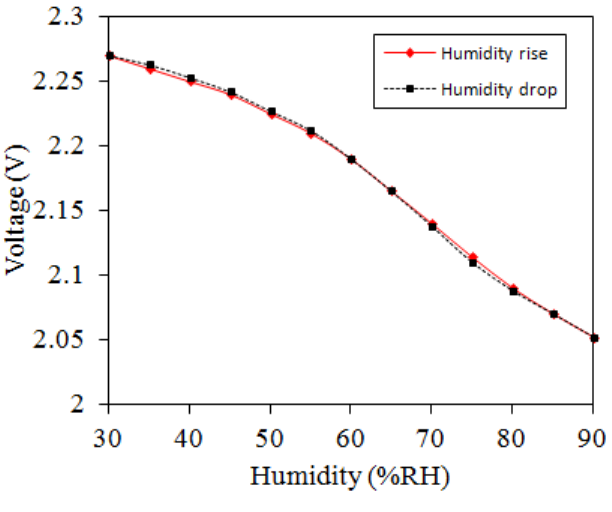
Figure 11. Measured results of the humidity sensor at 25 °C.